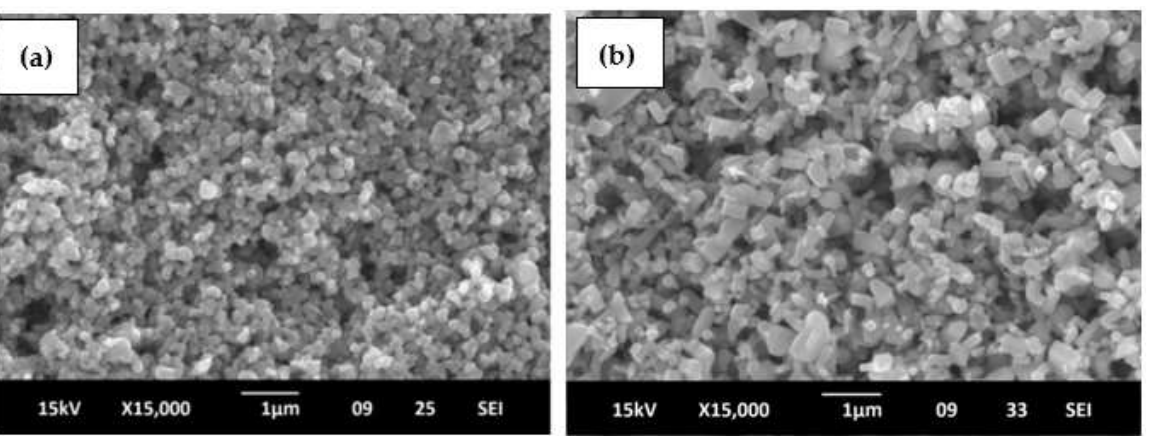
Figure 8. Light scattering effect on large particle size semiconductor photoanode material. The higher energy conversion efficiency of the ZnO photoanode is also supported by the material’s chemical characteristics, which include high electron mobility (200 cm 2 V −1 s −1 ) and large free excitation binding energy (60 meV) [25]. Thus, it was proved that ZnO has a higher energy conversion efficiency for a semiconductor photoanode than a TiO 2 photoanode. The electrical performance of DSSCs using various natural fruit dyes containing anthocyanin pigments is summarized in Table 2. The highest energy conversion efficiency for natural dye-based DSSC is found in the ZnO photoanode-based device with black